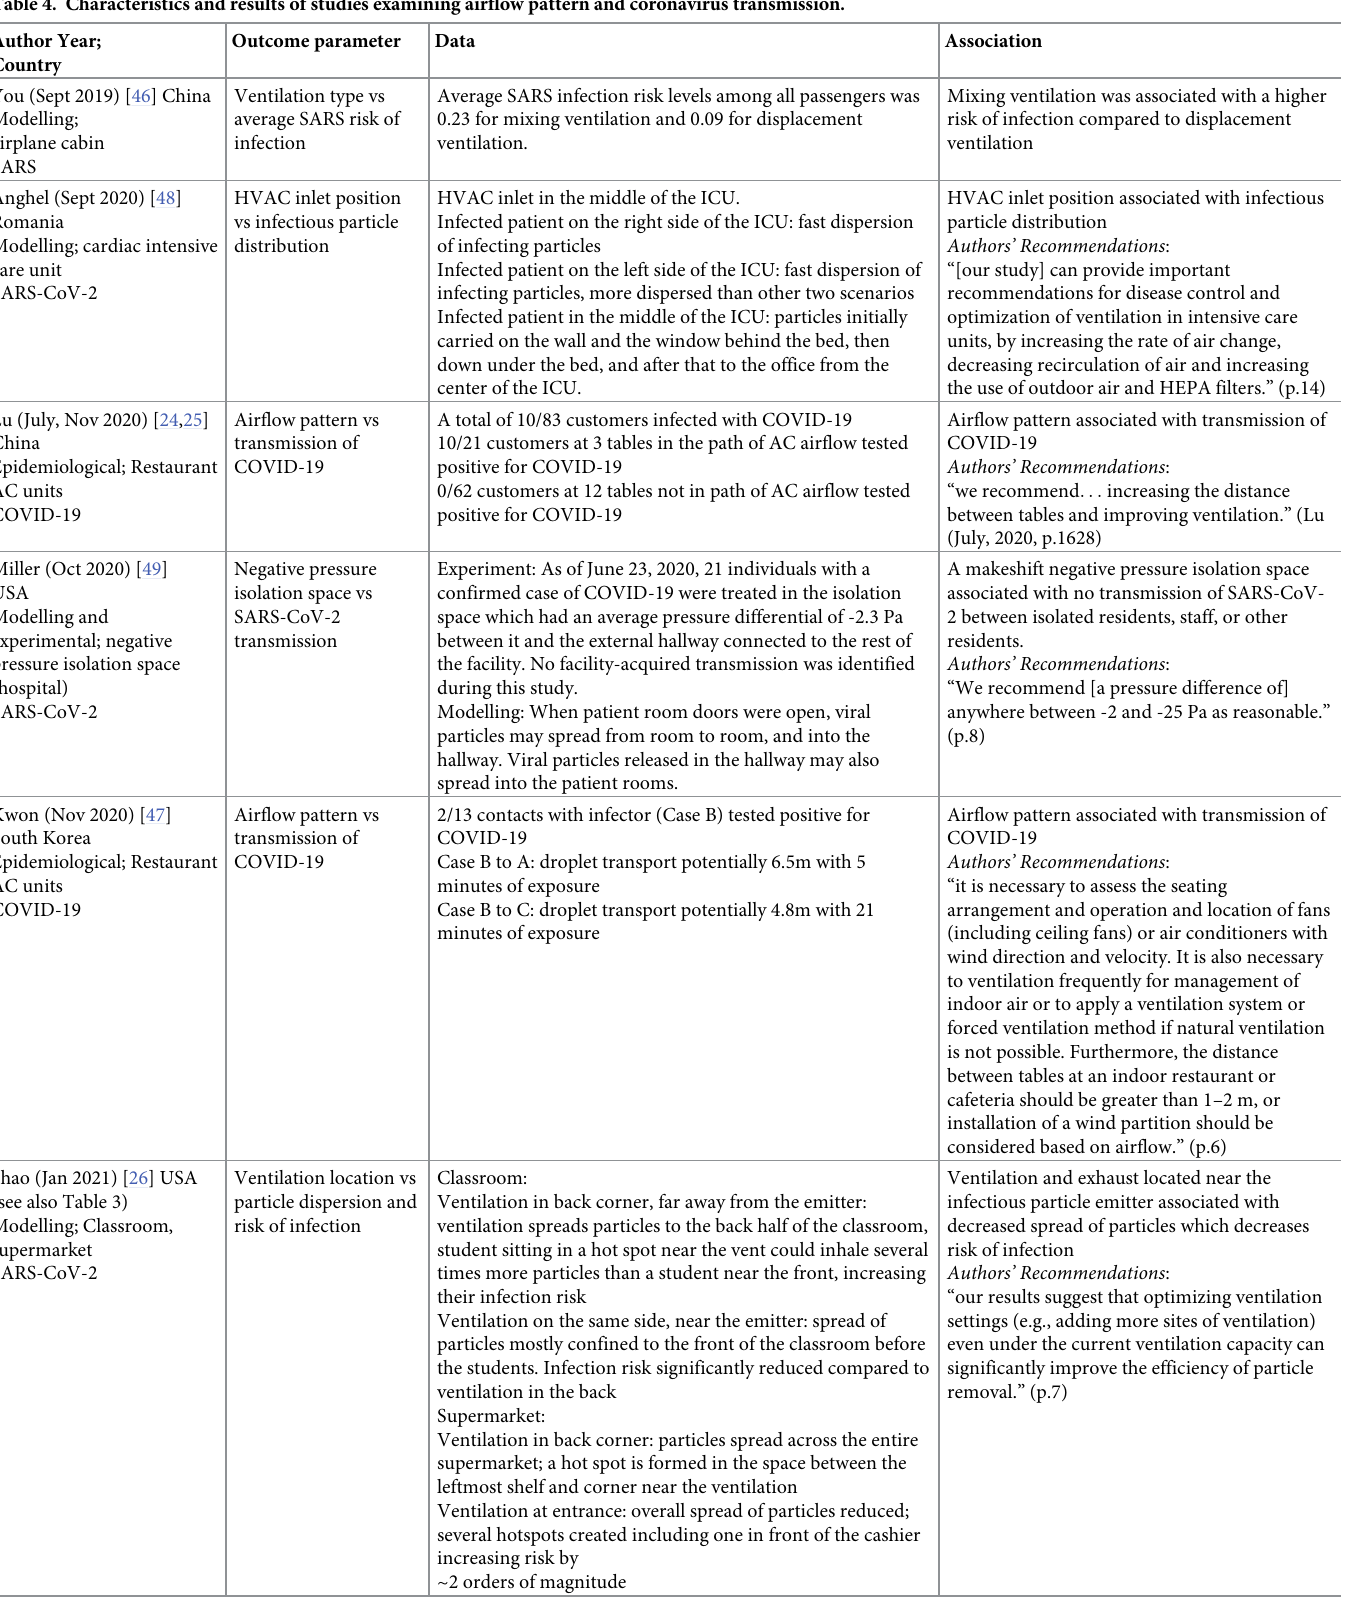
Table 4. Characteristics and results of studies examining airflow pattern and coronavirus